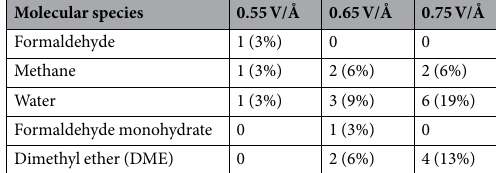
Table 1. Total populations (percent fractions) of the molecular species present in the system at the end of each simulation carried out at field strengths of 0.55 V/Å, 0.65 V/Å, and 0.75 V/Å. The fractions are determined as the ratio between the number of molecules of a given species and the number of total methanol molecules composing the original sample ( i . e ., 32). The lack of formaldehyde above the field threshold which is able to create it ( i . e ., 0.55 V/Å) is due to its extensive employment in diverse chemical reactions leading both to formaldehyde hydration both to DME synthesis. Formaldehyde acts as a reactive intermediate species which contributes to the complexification of the system.